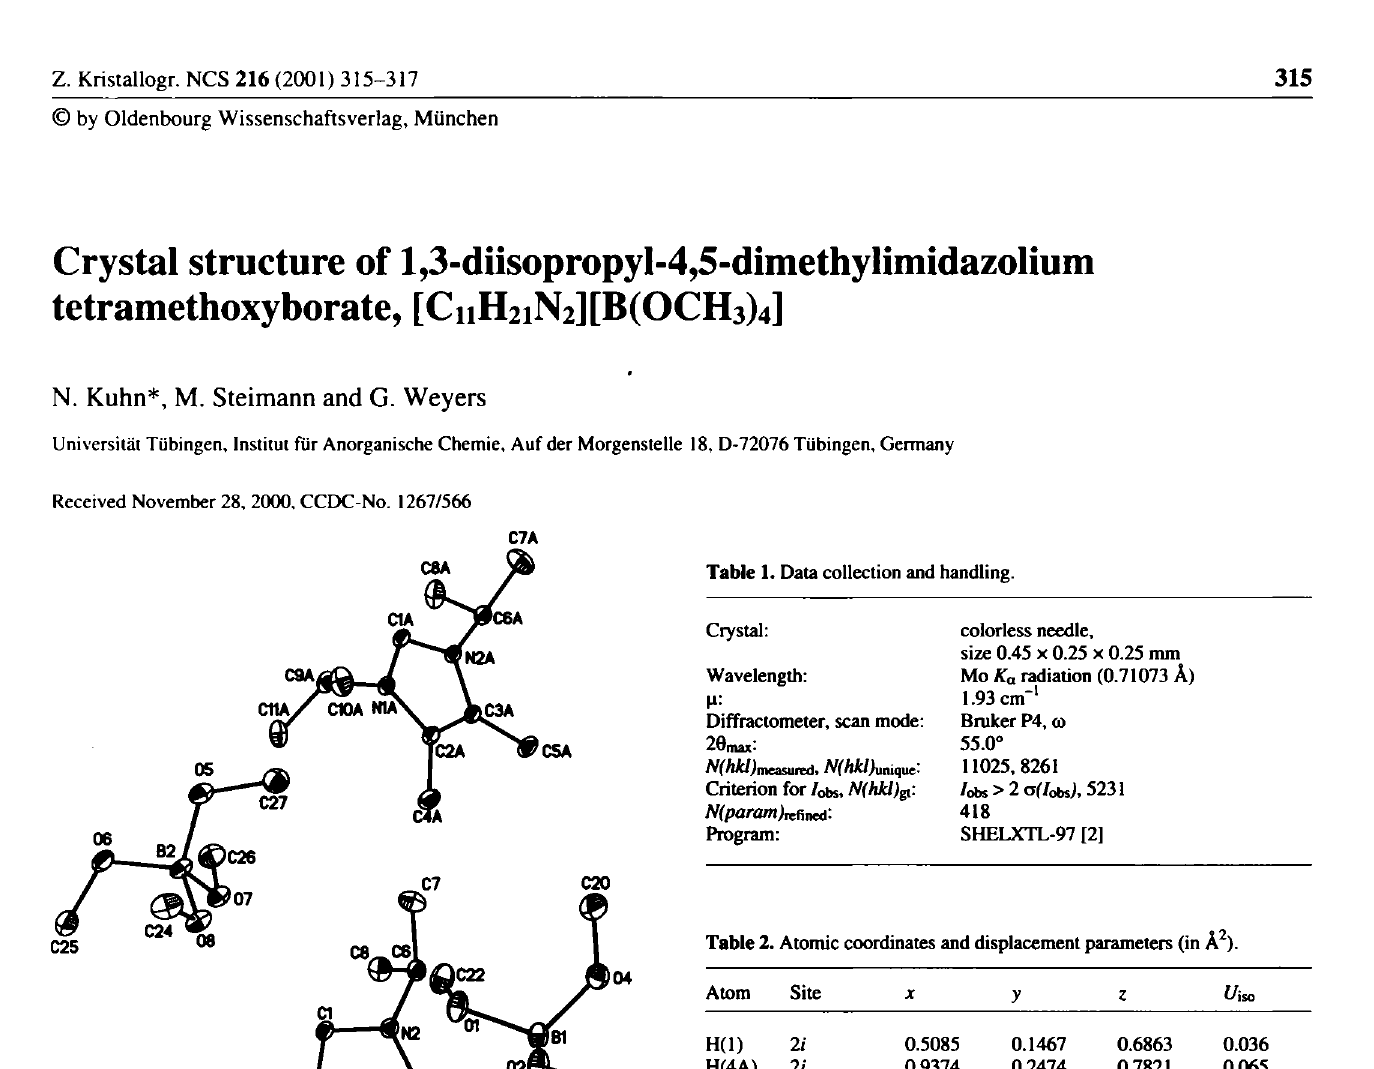
Table 2. Atomic coordinates and displacement parameters (in A 2